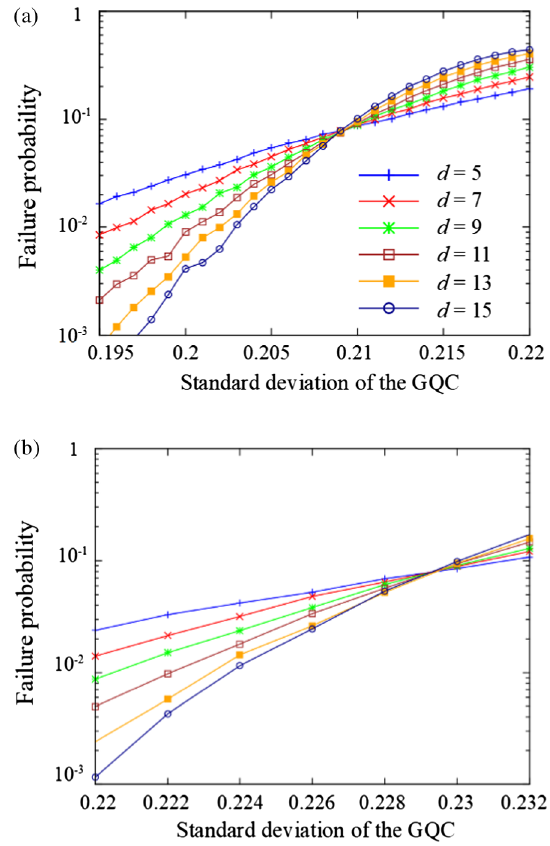
FIG. 7. Simulation results for the logical error probabilities of the surface code by using the 3D cluster state prepared by the ffiffiffi p ¼ 2 π = 5 with noisy syndrome mea- proposed method for v up surements using (a) the digital QEC and (b) the analog QEC, respectively. The simulation results for the digital QEC are obtained from 50 000 samples. The simulation results for the analog QEC are obtained from 10 000 ffiffiffi p 2 π = 5 in order to adopt the independent error model.